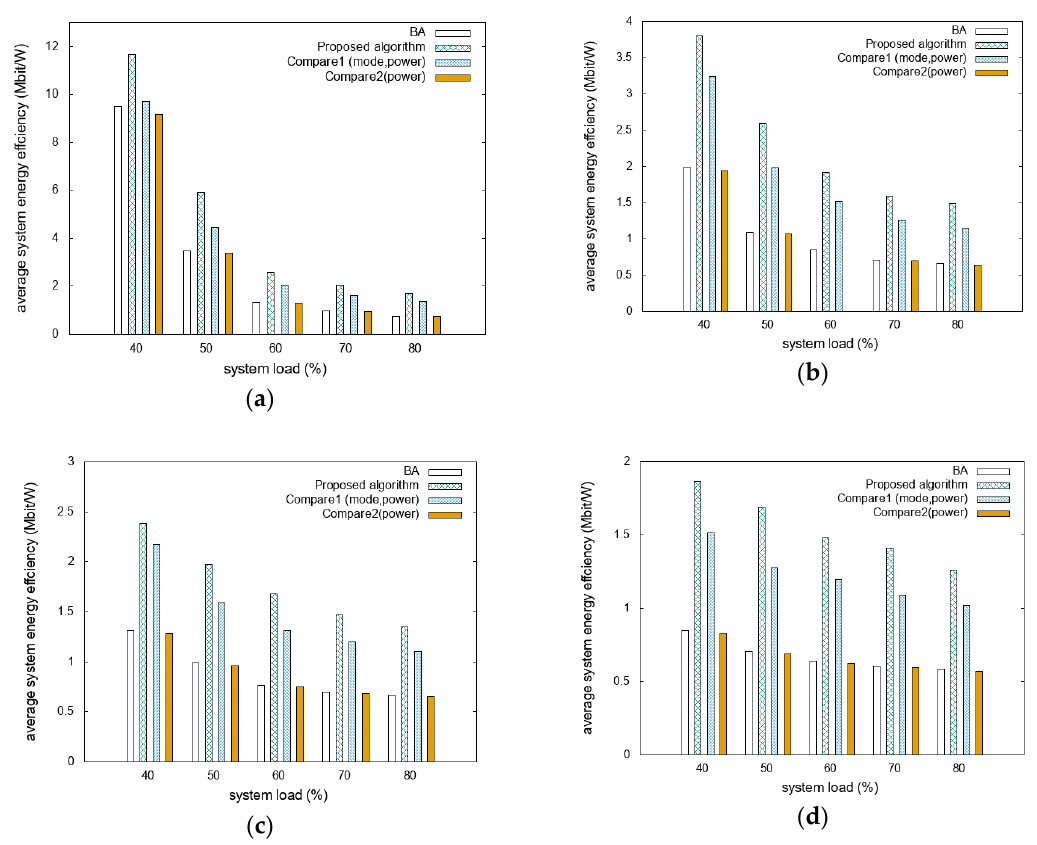
Figure 3. Comparison of system energy efficiencies with various device-to-device (D2D) distances and system loads: ( a ) 250 m with light traffic; ( b ) 350 m with light traffic; ( c ) 250 m with heavy traffic; and ( d ) 350 m with heavy traffic.